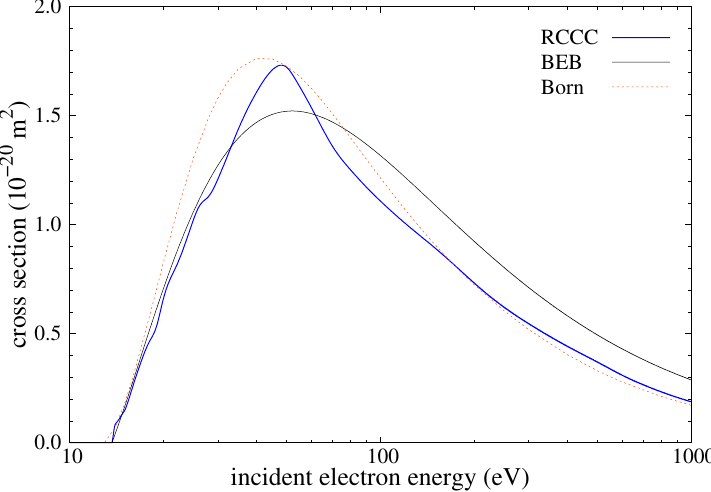
Figure 20. RCCC DI from the 5 s shell compared with the BEB results of Kim and Stone [16] and the Born results of Bartlett and Stelbovics